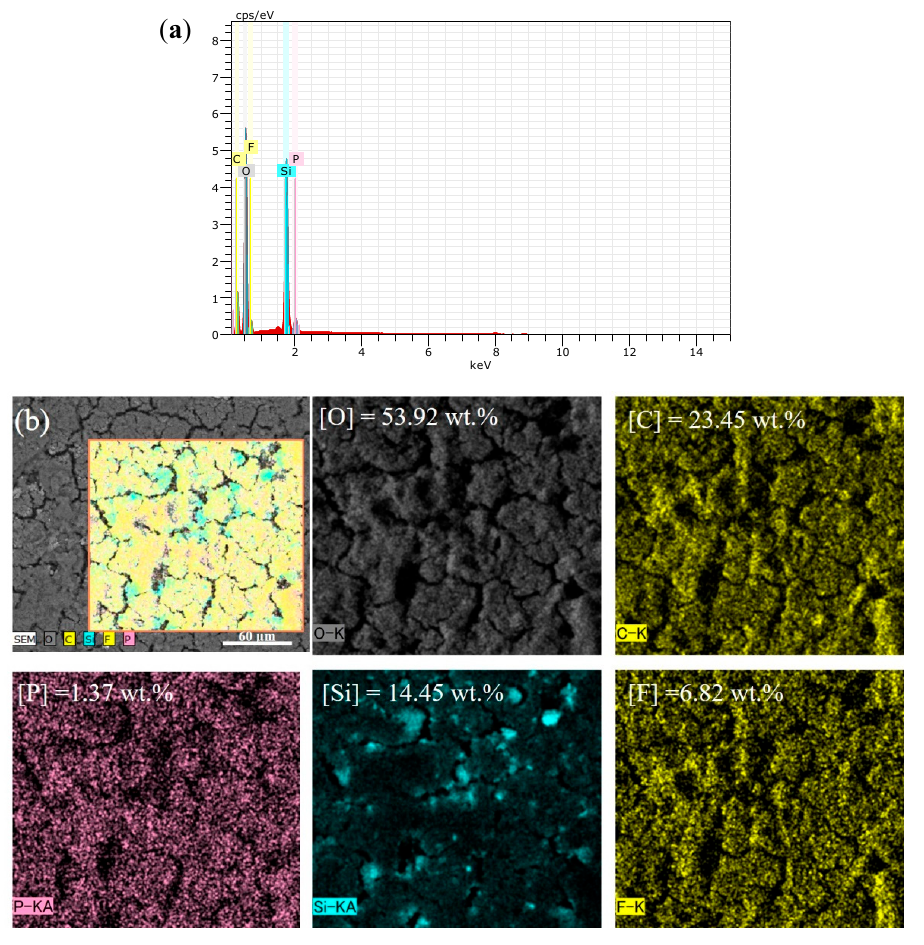
Figure 6. ( a ) EDX spectrum of Si anode after 100 cycles; ( b ) EDX maps of O, C, Si, F, and P on the Si anode.